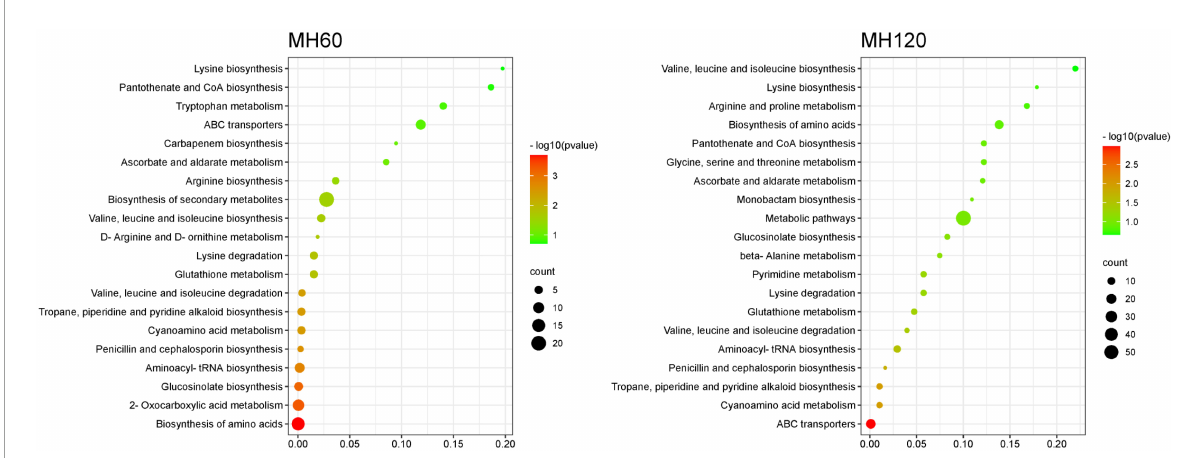
FIGURE7 Top 20 pathways of KEGG enrichment of SRMs in HD961.